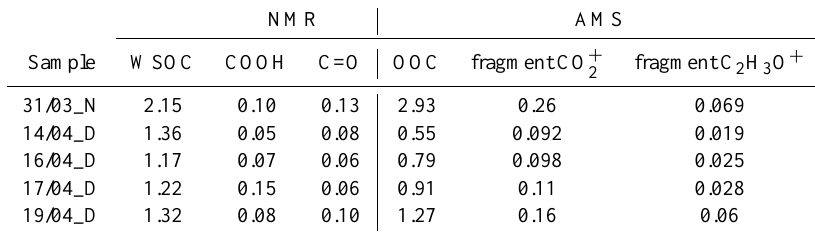
Figure 3. (a) 1 H-NMR functional group distribution of the SPC 2008 EUCAARI samples compared to submicron aerosol compositions derived from previous studies in the same area. Black dots represent the functional group distribution of the NMR factors derived from the factor analysis described in the following Sect. 3.4. (b) Time trend of aromaticity (defined as the ratio between aromatics and the sum of aliphatic groups). (c) Relative content of oxygenated aliphatic functional groups as a function of trace gas composition. Table 3. COOH and carbonyl concentrations from AMS and derivatization – 1 H-NMR analysis. All concentrations in µgCm − 3 . AMS OOC stands for the carbon concentrations of all OOA types and BBOA.